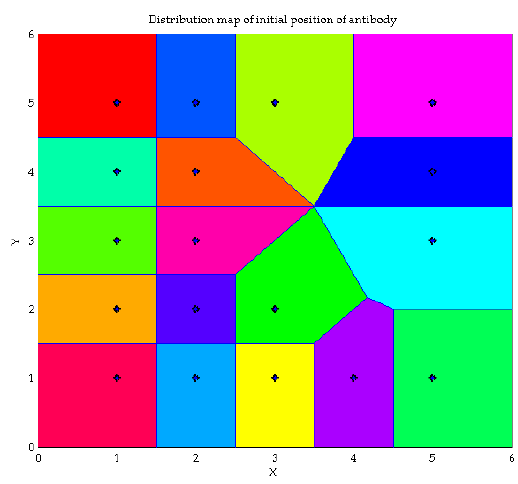
Figure 8. Initial position distribution of antibodies under multi-objective optimization.